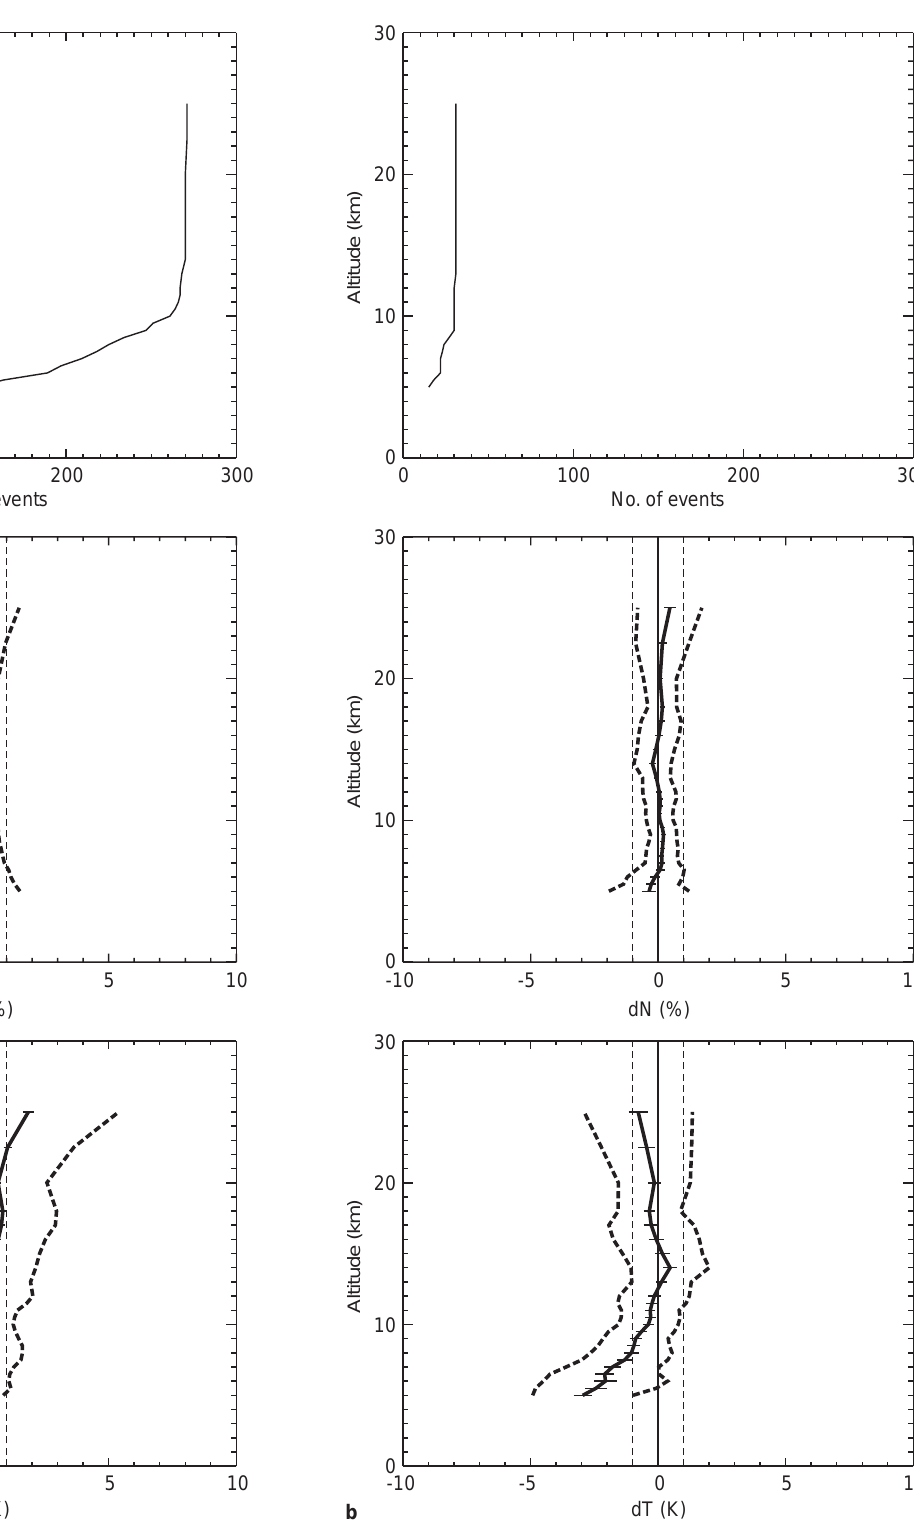
denote the di(cid:128)erences of means (bias profiles), the dotted lines denote the standard deviations of di(cid:128)erence profiles, and the horizontal bars depict the standard error in the bias profiles. Validation results are shown for a the whole global data set of October 20/21, 1995 b, for the Europe + USA area c, and for the South Pacific area For continuation of Fig. 10 please see page